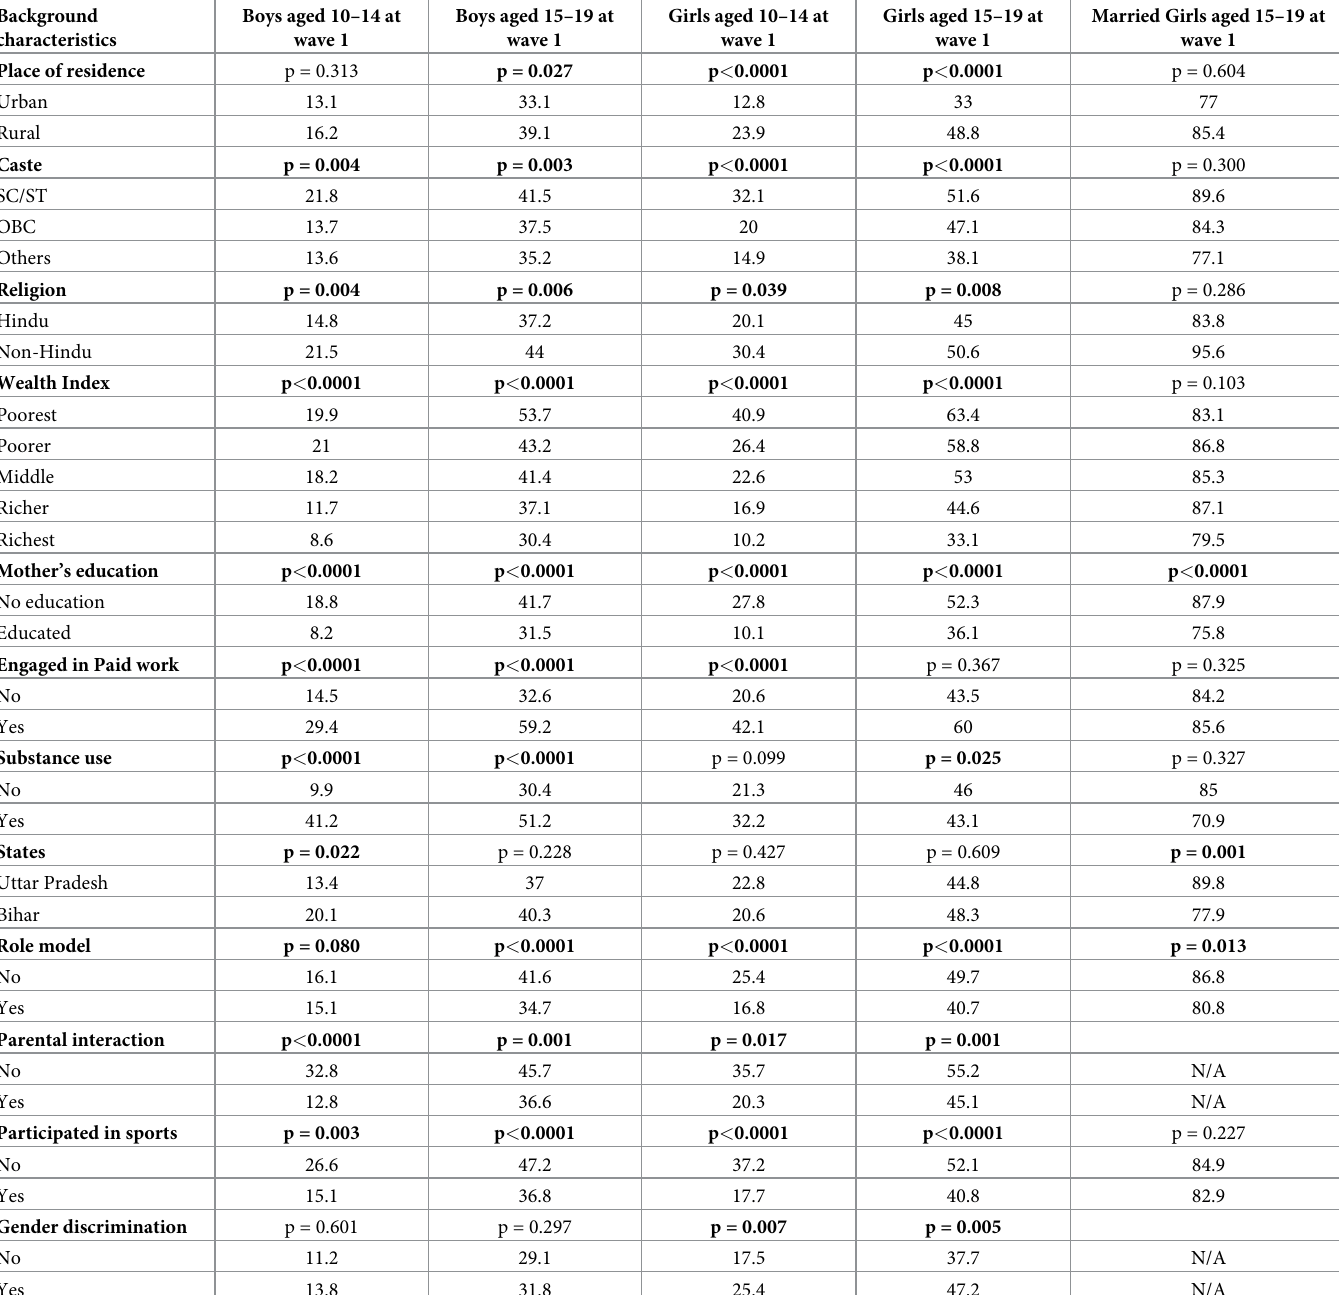
Table 2. Bivariate association of socio-economic and demographic factors with school dropouts among adolescent boys and girls, 2018–19. Background